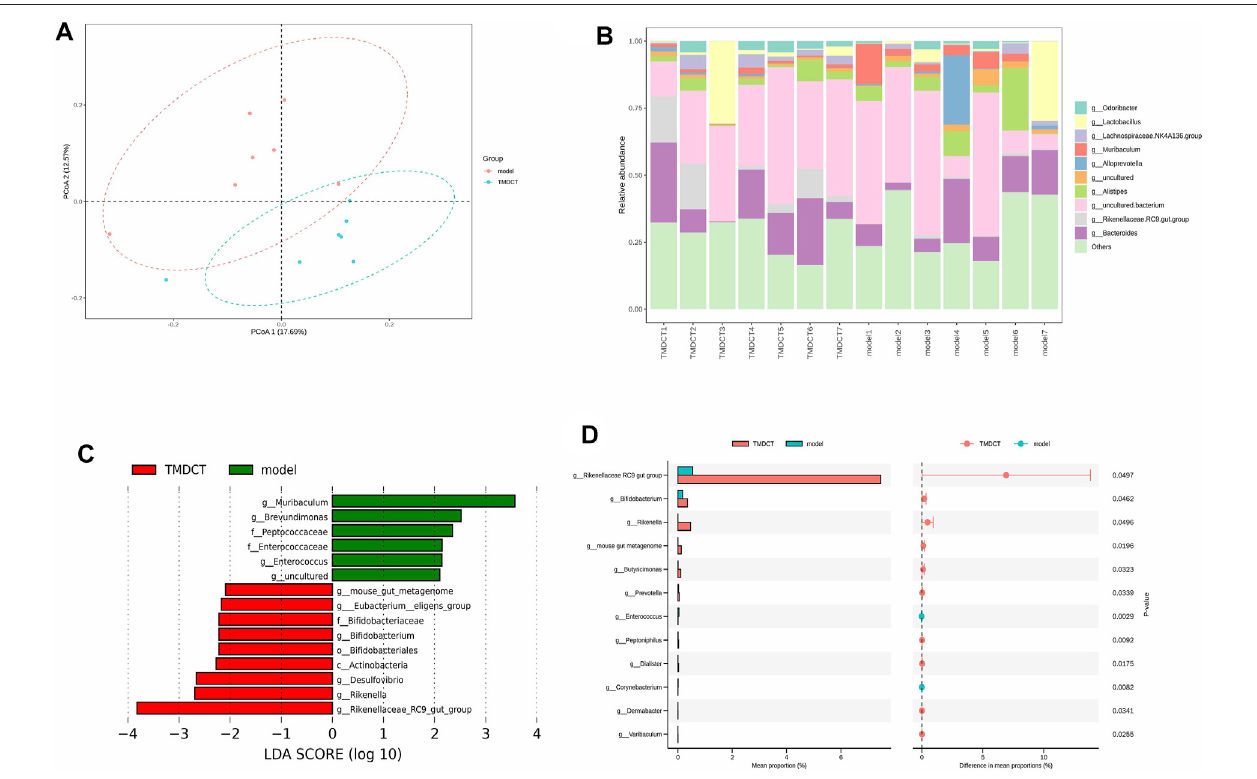
FIGURE 5 | TMDCT signi fi cantly changed gut microbiota composition. (A) Principal Co-ordinates Analysis (PCoA) analysis in each group. (B) Relative abundance of gut microbiota in each group. (C) Key phylotypes of gut microbiota in response to TMDCT interventions (LDA method was used). (D) Signi fi cantly difference gut microbiota analysis, STAMP difference analysis method was used. n = 7 animals per group.